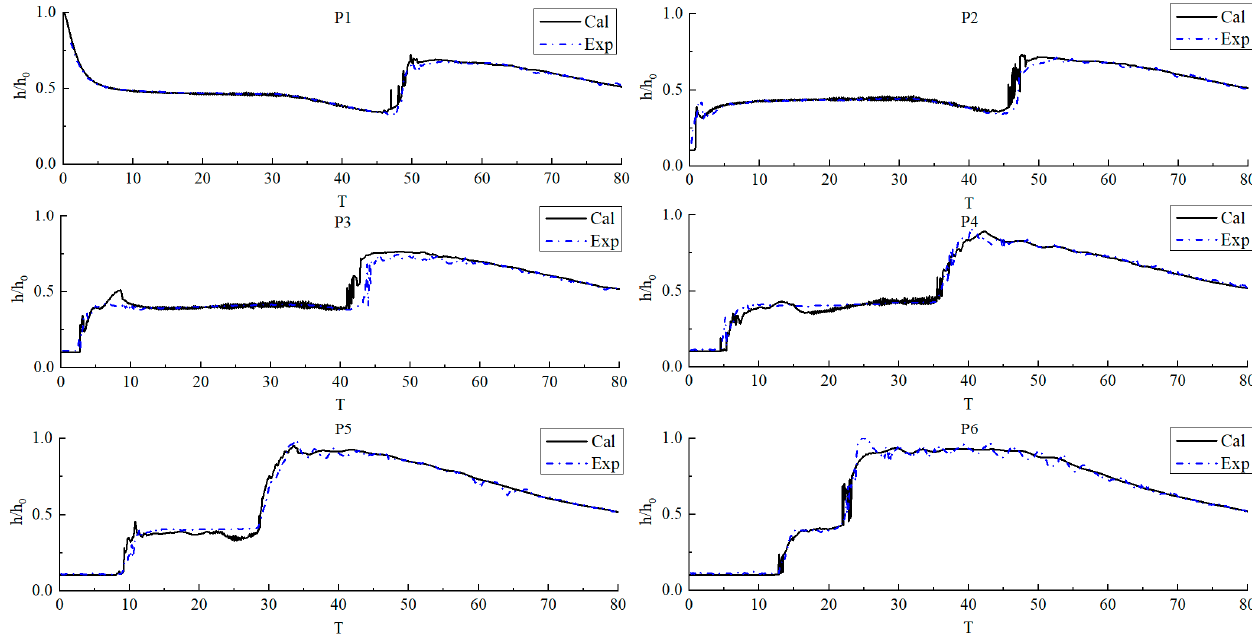
Figure 18. Altitude changes at 6 positions.